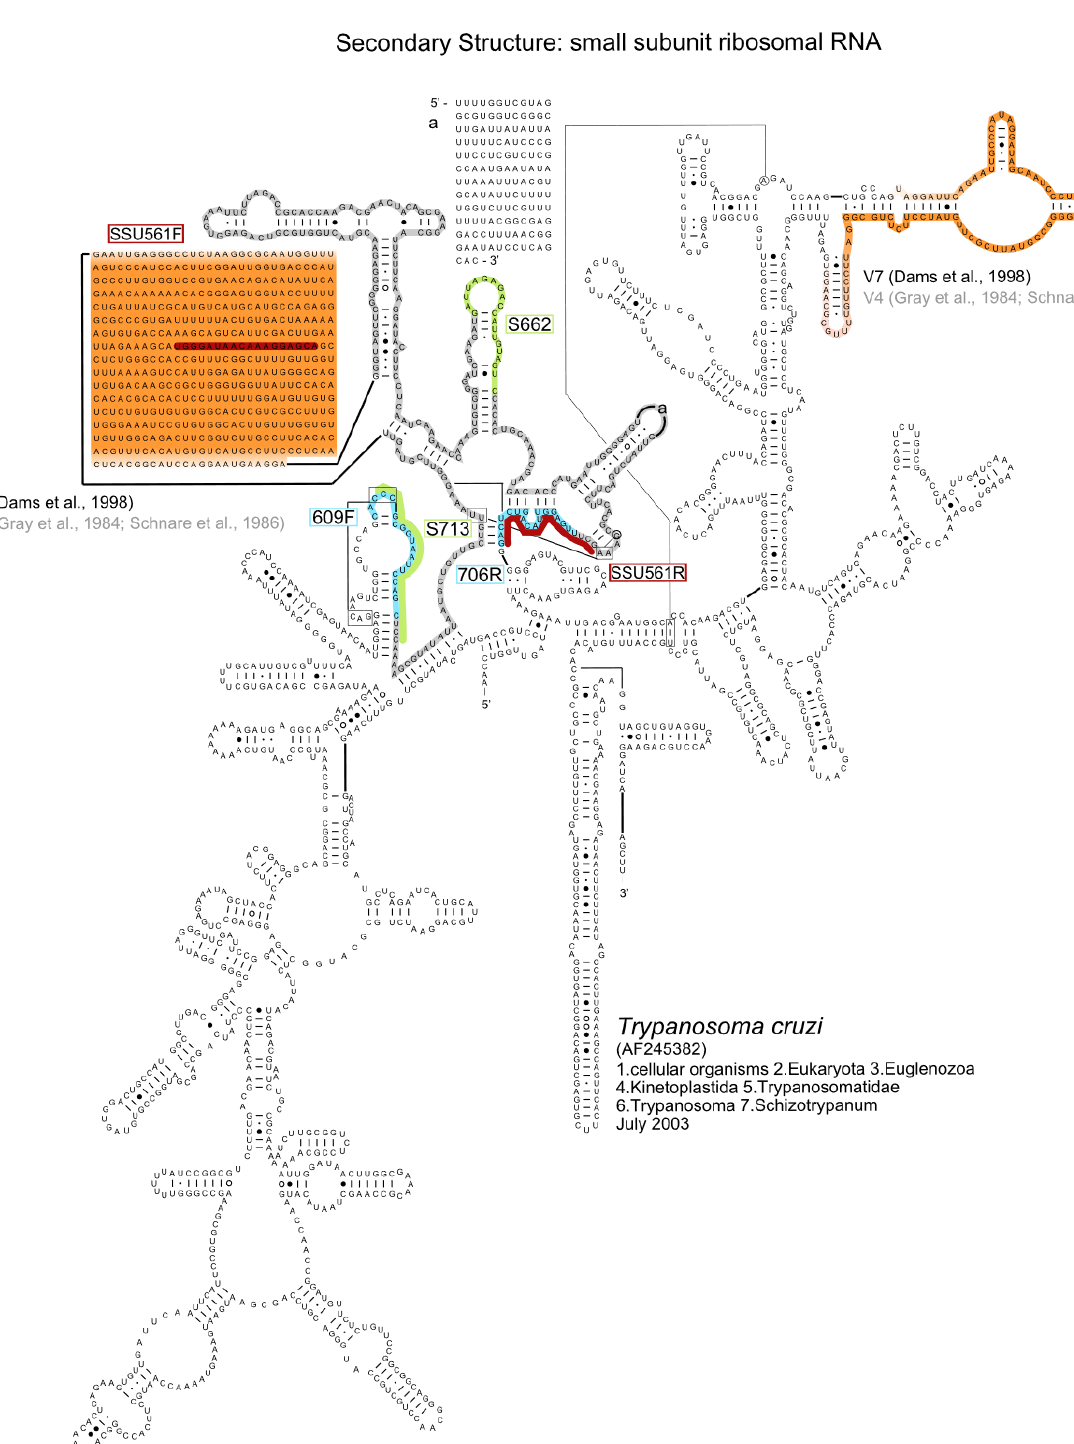
Figure 2. 18S rRNA secondary structure of T. cruzi obtained from CRW [28]. For regions with pseudoknots, only the primary sequence is shown. The variable regions V4 and V7, according to Dams et al. [11], Gray et al. [6], and Schnare et al. [7], were highlighted in orange and yellow. Primers used in Maia da Silva et al. [27], Noyes et al. [33], and Vot ý pka et al. [29,30] are highlighted in blue, red, and green, respectively. The sequenced region was highlighted in